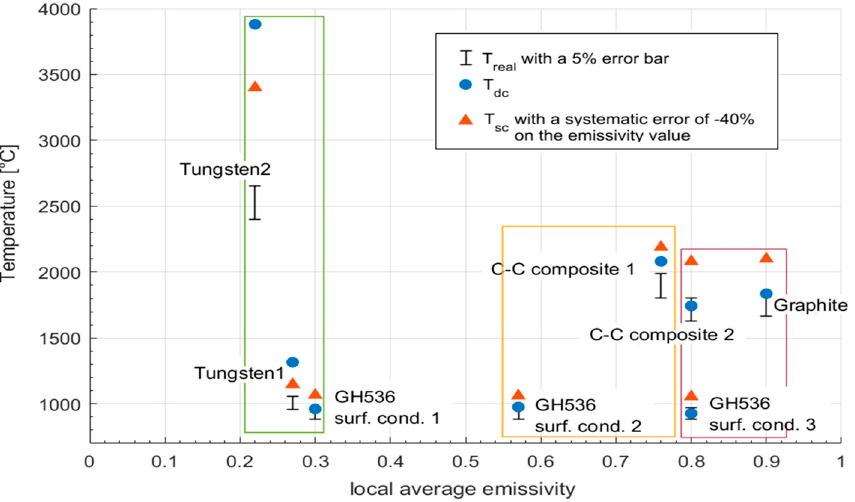
Figure 12. Dual-color versus standard thermographic techniques performance at high temperature for different emissivity classes of materials in the near-infrared spectral